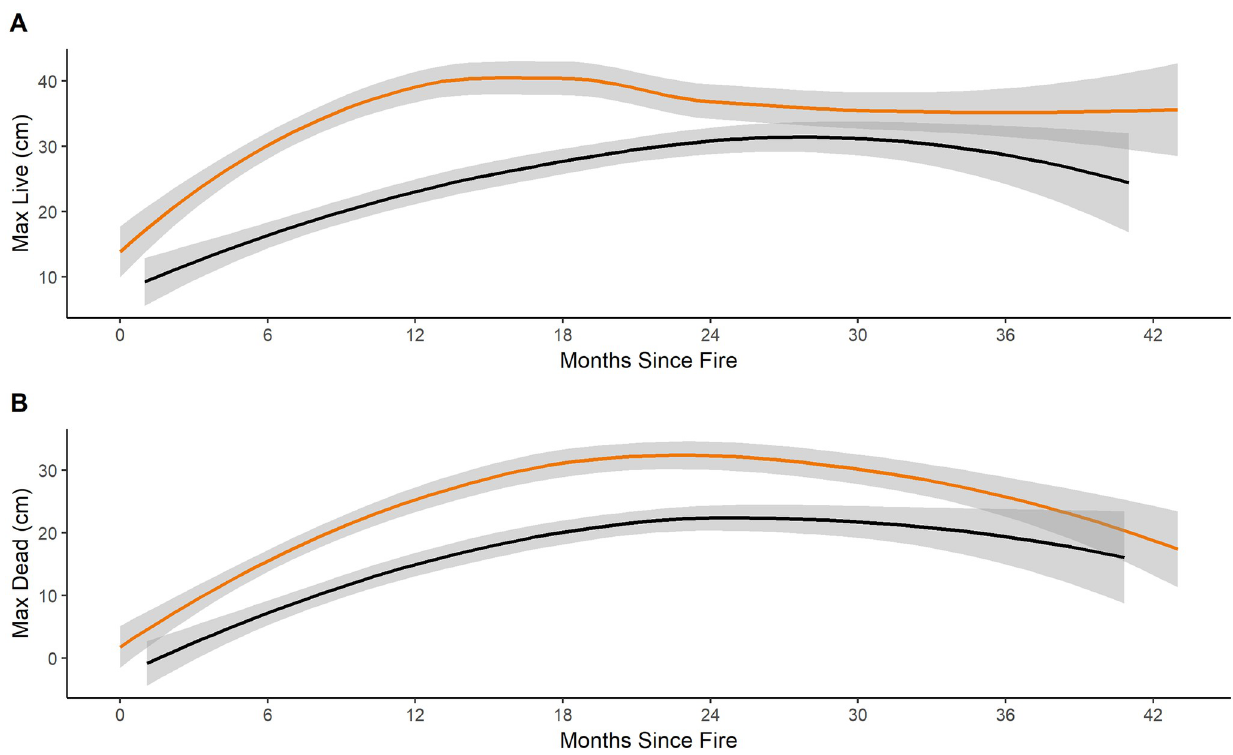
Fig 7. Maximum live and dead vegetaton. Maximum heights (cm) of live (A) and dead (B) vegetation in fire-only (orange) and pyric herbivory (black) treatments at all sites from 2014 to 2016. Shaded area indicates 95% confidence interval. � Regression lines and confidence intervals generated using “loess” locally-weighted smoothing